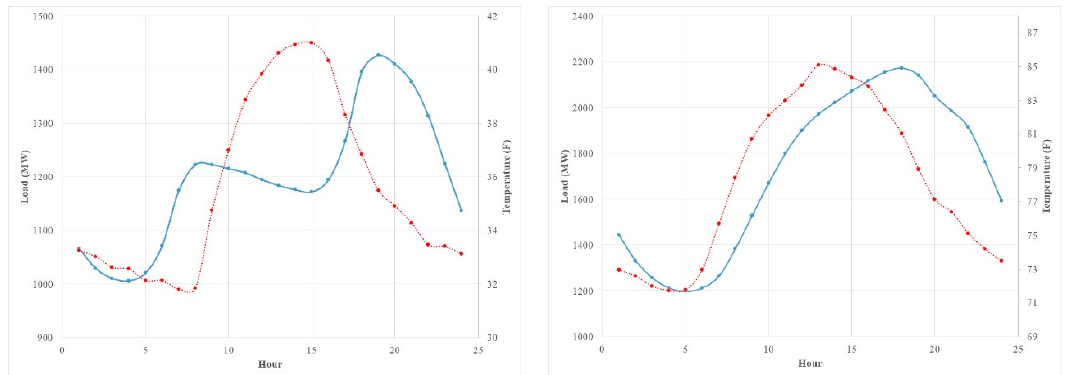
Figure 3. The average of 24-hour load curves (blue solid) and the temperature (red doted) ( left : January 2013; right : July 2013).